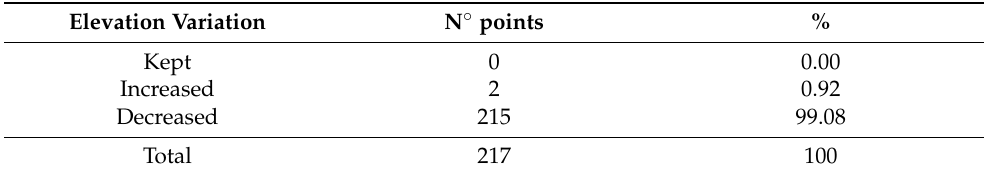
Table 4. Altimetric differences in the waste pile between the first and last campaigns.